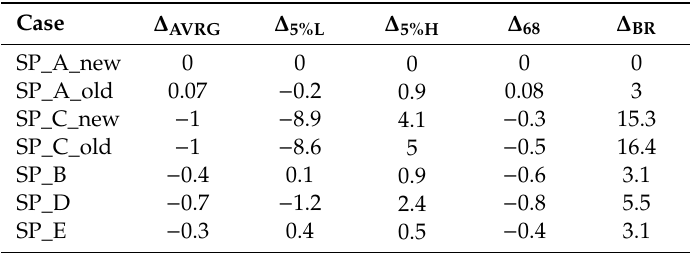
Table 6. Analysis of the di ff erences in the burnup distribution parameters in comparison with the SP_A_new case as a reference ( ∆ j * , GWd /